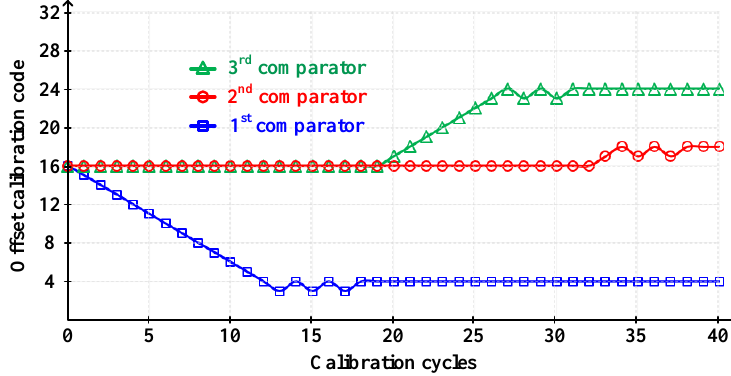
Figure 17. The offset calibration convergence for differential-difference comparators (DDCs). Figure 17. The o ff set calibration convergence for di ff erential-di ff erence comparators (DDCs).